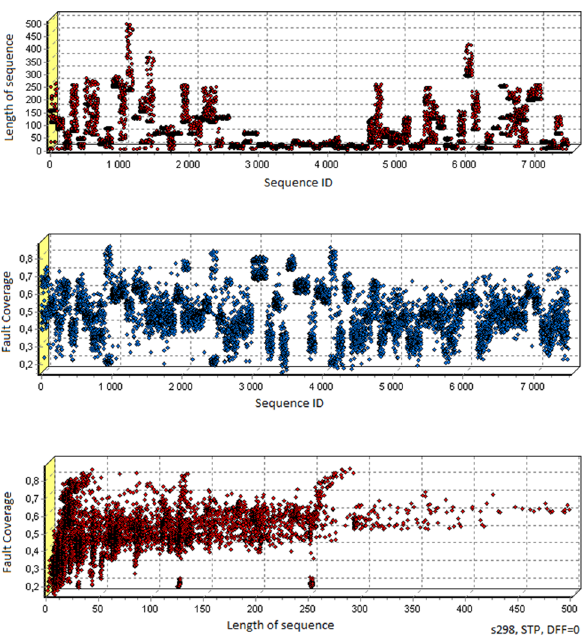
Fig. 21 STP for s298 without use of internal flip-flops